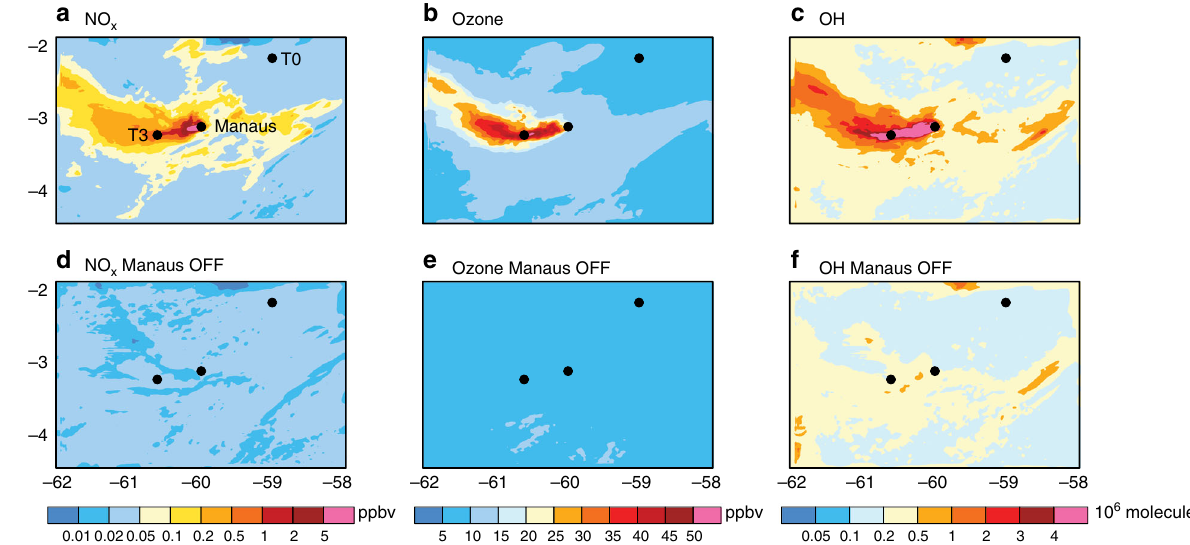
Fig. 3 WRF-Chem simulated concentrations of NO x and oxidants with Manaus emissions turned on/off. a , b , and c show simulated NO x , ozone and OH with all emissions on, while d , e and f show simulations with biogenic emissions on but Manaus emissions turned off for an altitude of ~500 m, averaged during the afternoon (16 – 20 UTC) of 13 March 2014. A comparison of top and bottom panels demonstrates how NO x and oxidants are greatly enhanced by